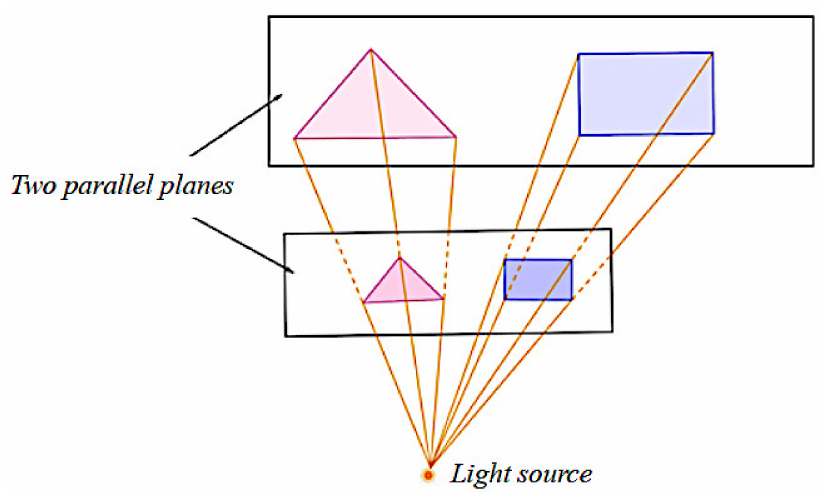
Figure 3. Illustration of similarity found in a 1980s’